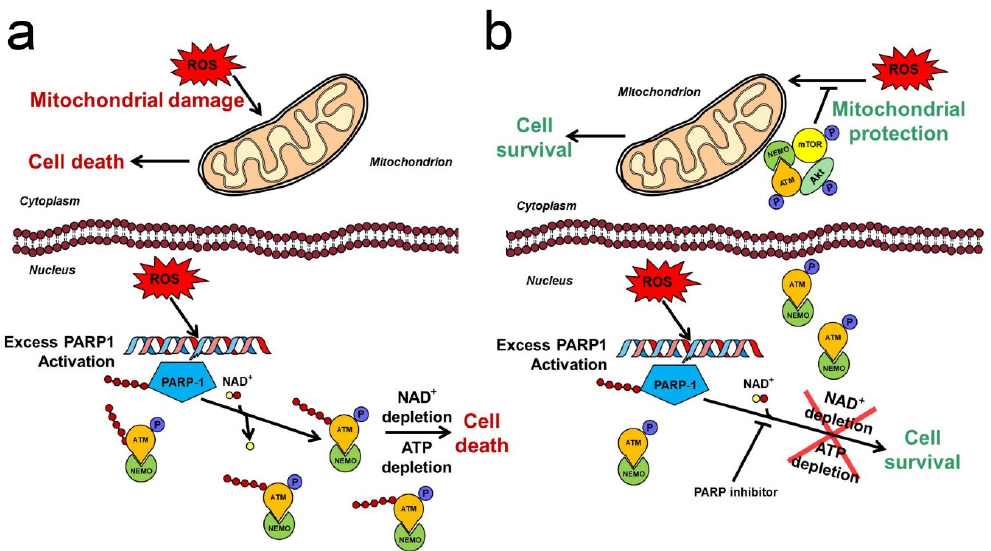
Figure 1. Interplay of poly(ADP-ribose) polymerase (PARP) with Akt-mediated mitochondrial protection in oxidative stress. ( a ) E ff ects of oxidative stress in the absence of PARP inhibition. ROS-induced DNA strand breaks induce excess PARP activation leading to NAD + then ATP depletion. PARylated ATM–NEMO are retained in the nucleus. ROS-induced mitochondrial dysfunction contributes to cell death caused by energy failure. ( b ) E ff ects of oxidative stress in the presence of PARP inhibition. The PARP inhibitor blocks excess PARP activation and NAD + consumption. Activated ATM–NEMO complex translocates to the cytoplasm and attaches to the outer mitochondrial membrane. Akt and mTOR are complexed with ATM–NEMO to form an ATM–NEMO–Akt–mTOR signallosome. Akt becomes activated and protect the mitochondria against the ROS-induced damages. Pointed arrows denote activation while arrows with flat end represent inhibition. P indicates phosphorylation. Red and yellow spots designate ADP-ribose and nicotinamide, respectively.